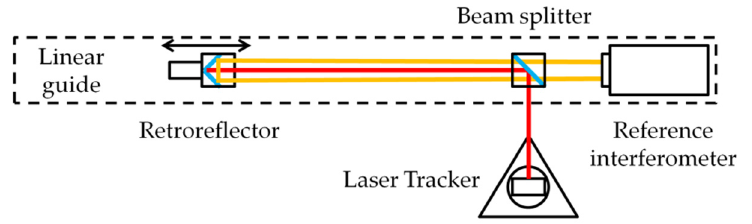
Figure 1. The simplified diagram of test station: red line—laser tracker beam, orange line—reference interferometer beam.